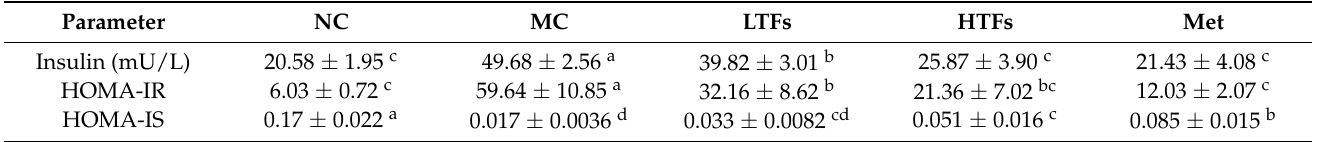
Table 1. Changes in HOMA-IR and HOMA-IS of T2DM